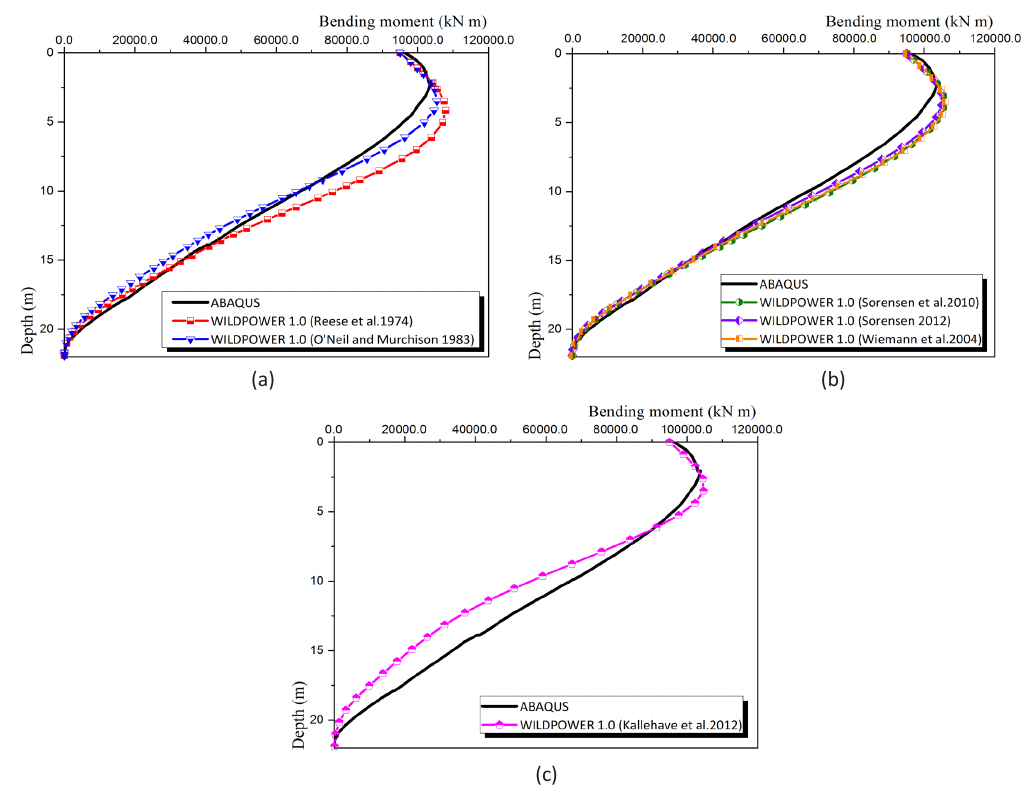
Figure 5. Profiles of bending moments.